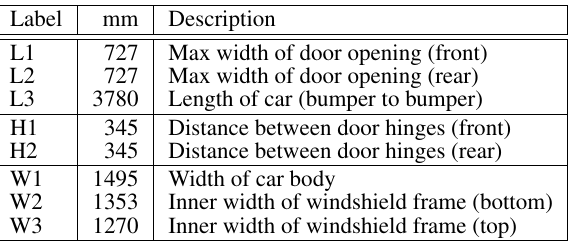
Table 1. Benchmark VW Thing dimensions, categorized as Lengths, Heights, and Widths.